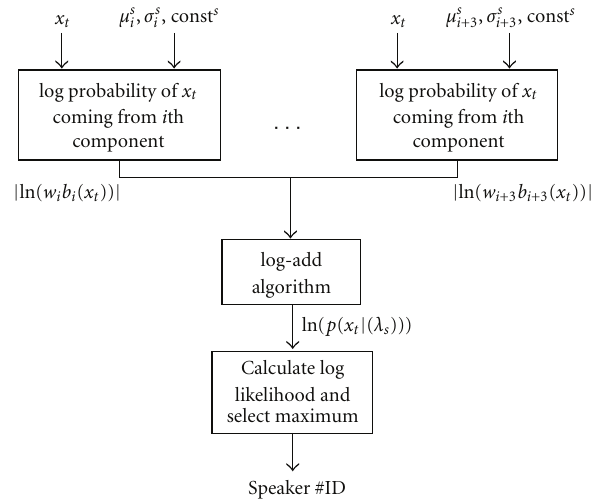
Figure 6: Datapath broken down into 3 segments.